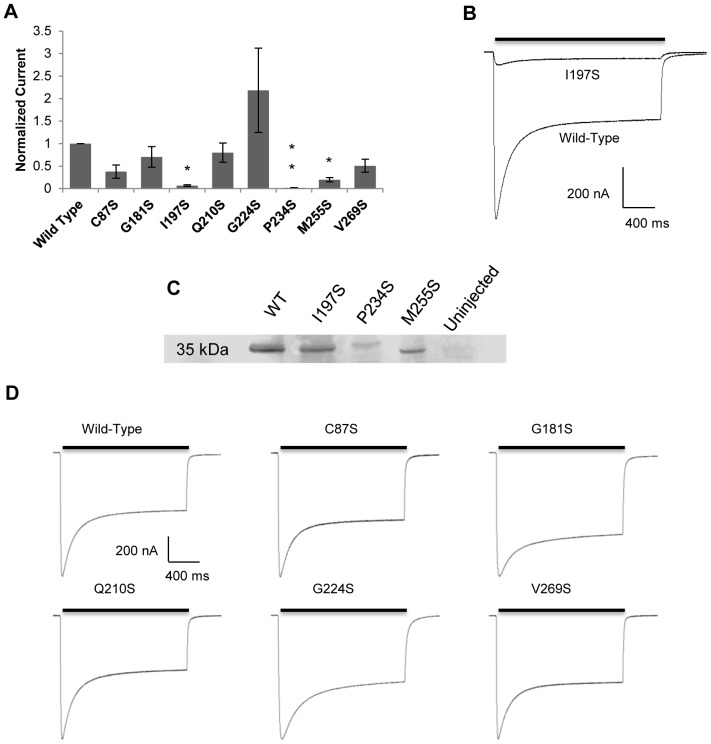
Representative ChR2 photocurrent traces recorded at −120 mV.Black bars indicate illumination with 473 nm light. (A) Normalized photocurrent traces. Mutant photocurrents were normalized to WT ChR2 on the same day in 115 mM Na+ solution at pH 9. Values are reported as mean±S.E.M (n = 3–9). Statistically significant values are denoted by a *(*P<0.001; **P<0.04). (B) Reduced photocurrent for I197S compared to WT ChR2 on the same day. M255S and P234S had similar results. (C) Western blot of I197S, P234S, and M255S ChR2 mutants. ChR2-HA tagged band appears at ∼35 kDa. (D) Typical electrophysiological recordings for single serine mutants. Mutants retained inward rectification of cations, but with altered permeability, kinetics, and/or inactivation ratios.